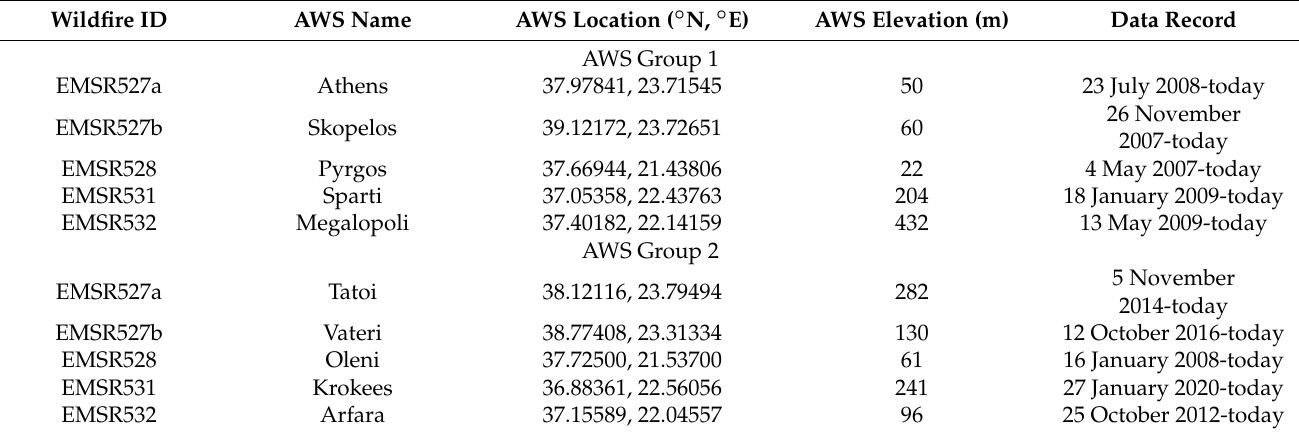
Table 2. Description of the AWSs used in the present